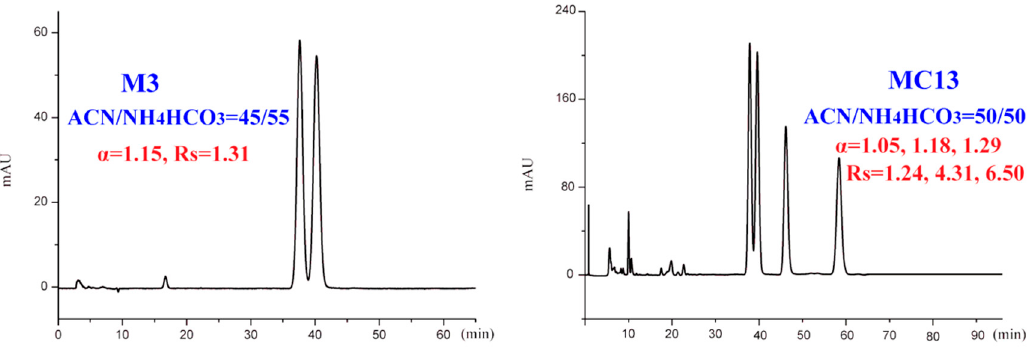
Figure 8. Typical chromatograms with better resolution under optimized conditions of reversed-phase mode. ACN: Acetonitrile.